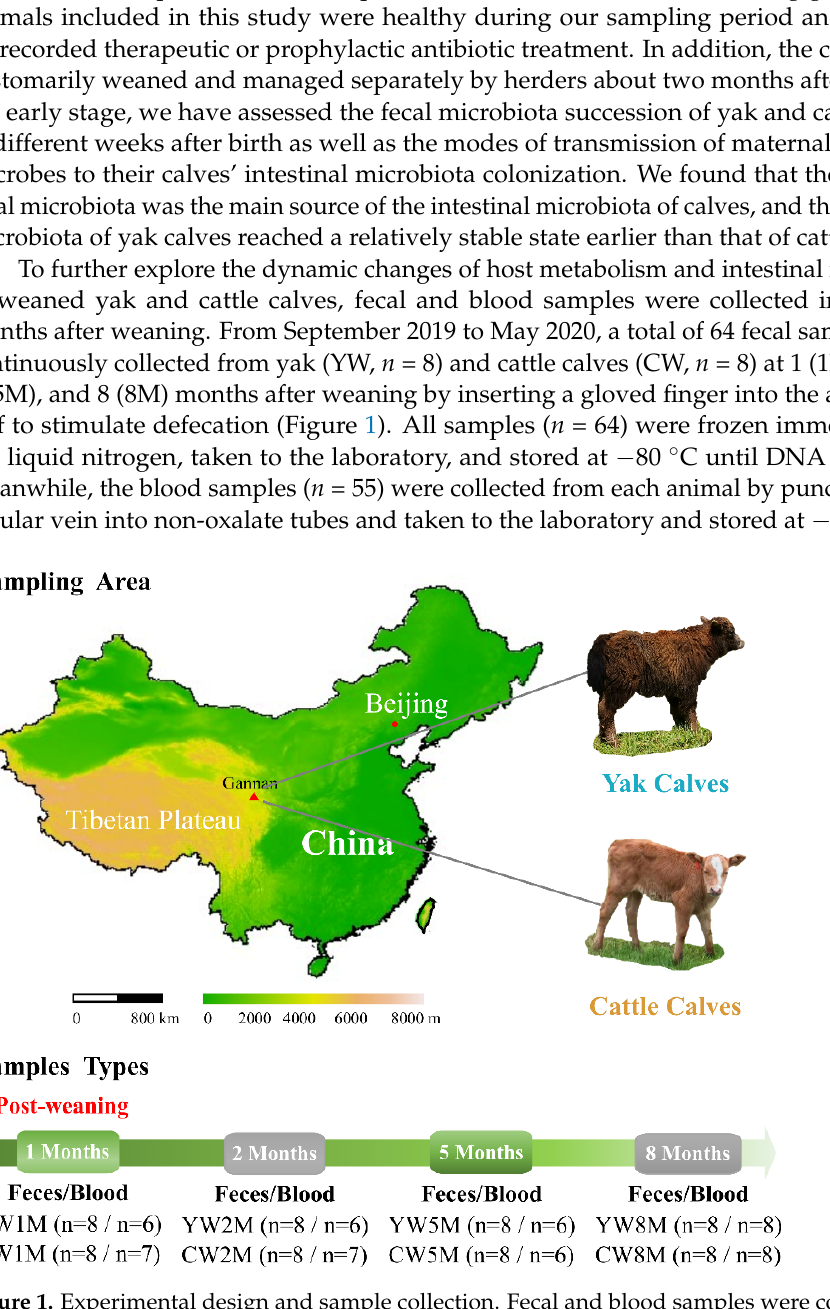
Figure 1. Experimental design and sample collection. Fecal and blood samples were continuously collected from yak and cattle calves in different months after weaning on the same pasture.